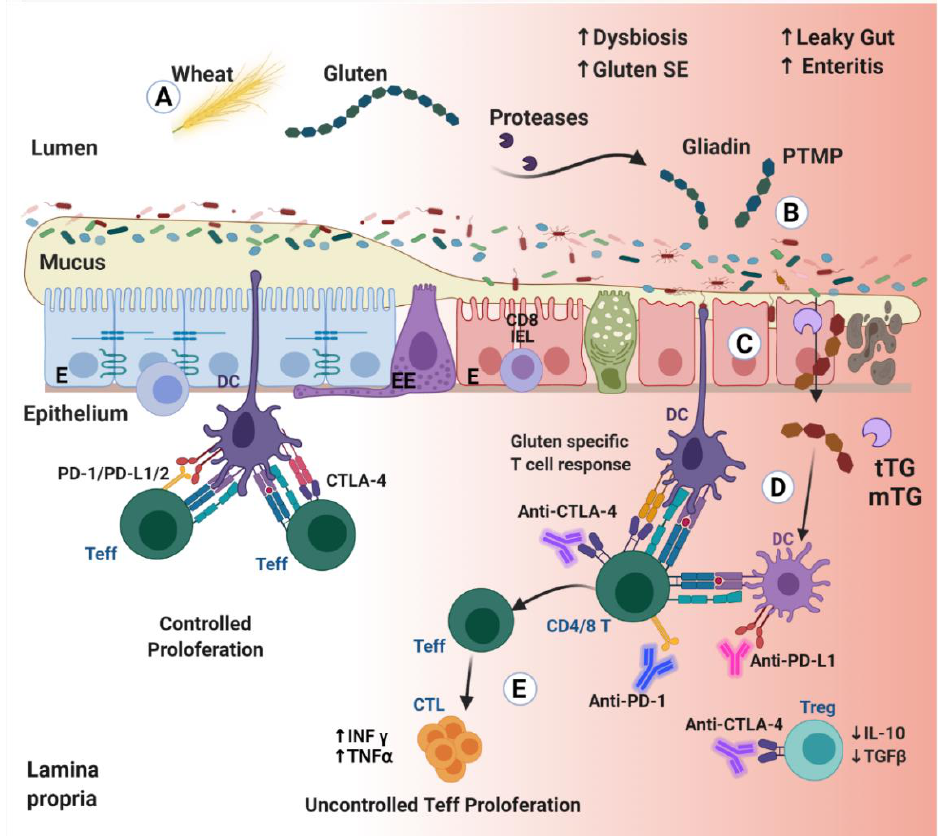
Figure 2. Immune checkpoint inhibitors and celiac disease. ( A ) Gluten is ingested and digested, reaching the gut lumen as gliadin peptides. ( B ) Gliadins are rich in glutamine and proline, thus are a prime substrate for deamidation and cross-linking by luminal and mucosal transglutaminases, thus, turning those naïve molecules into immunogenic ones. Transglutaminase capacity to deamidate or transamidate, results in increased post-translation modified proteins (PTMP). Luminal di- gestive peptidases cannot further break down those bonds, hence, inducing gut inflammation, mu- cus disruption and intestinal epithelial damage. ( C ) Gluten increases intestinal permeability by binding to epithelial CXCR3 receptors, resulting in zonulin release. Gliadin-transglutaminase trans- formed peptides can potentially infiltrate through the open junctions or trans-enterocytically into the lamina propria. A breach in the epithelial barrier exposes the highly immunoreactive sub-epi- thelium to luminal foreign antigens, stimulating the local immune system. ( D ) In the lamina propria, gliadin-transglutaminase cross-linked complexes induce pro-inflammatory cytokines. Two types of DC are present, sub-epithelial DCs that send protrusions into the lumen and sense the gut microbi- ota, and the lamina propria DCs that migrate to lymph nodes, where they present antigens and activate T cells. Immune checkpoint inhibitors block co-inhibitory pathways unleashing effector T cells and depleting regulatory T cells. ( E ) Uncontrolled activation and proliferation of cytotoxic T lymphocytes (CTLs) further aggravate barrier perturbation, secreting IFNγ and TNFα cytokines, leading to severe intestinal damage. Author Contributions: A.L. screened the literature, designed and wrote the manuscript, C.B. screened the literature, edited and revised the manuscript, designed the figure with BioRender.com permission. All authors have read and agreed to the published version of the manuscript. Funding: This research received no external funding. Conflicts of Interest: The authors declare no conflicts of interest.